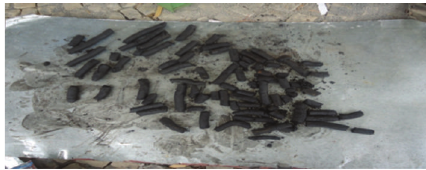
Figure 4: The produced briquettes while